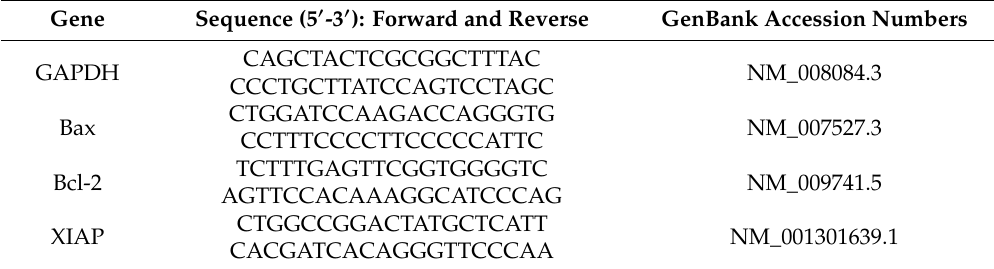
Table 1. Primer sequence for